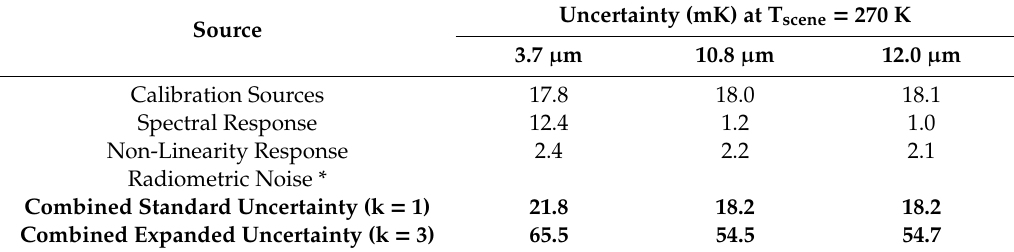
Table 4. Main sources of uncertainty in radiometric calibration of the SLSTR instrument and typical estimates for a scene brightness temperature at 270 K for the calibration tests. Uncertainties are reported at k = 1 and expressed in brightness temperature in mK. Combined uncertainties are reported at k = 1 and k =